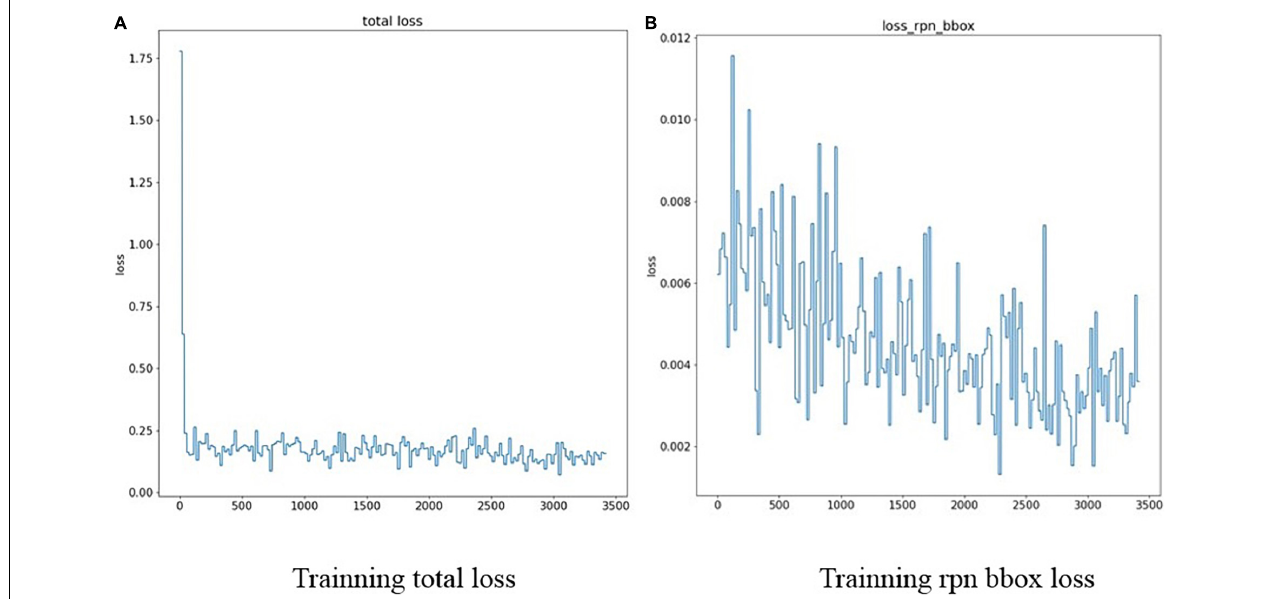
FIGURE 11 | Training loss diagram (A) training total loss (B) training RPN bbox loss.